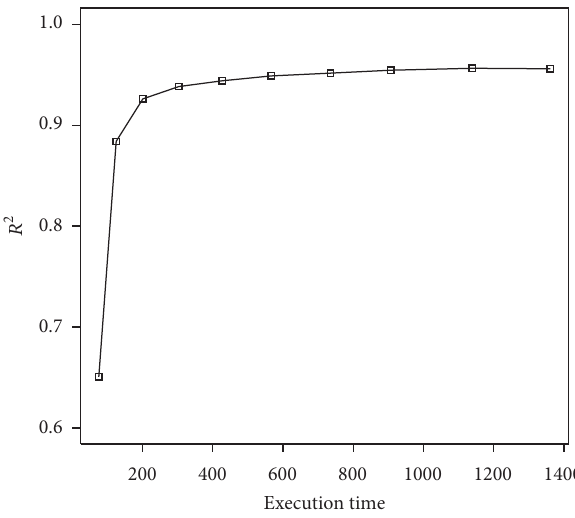
Figure 9: Forecast quality dependence on execution time of PLM algorithm for synthetic data.